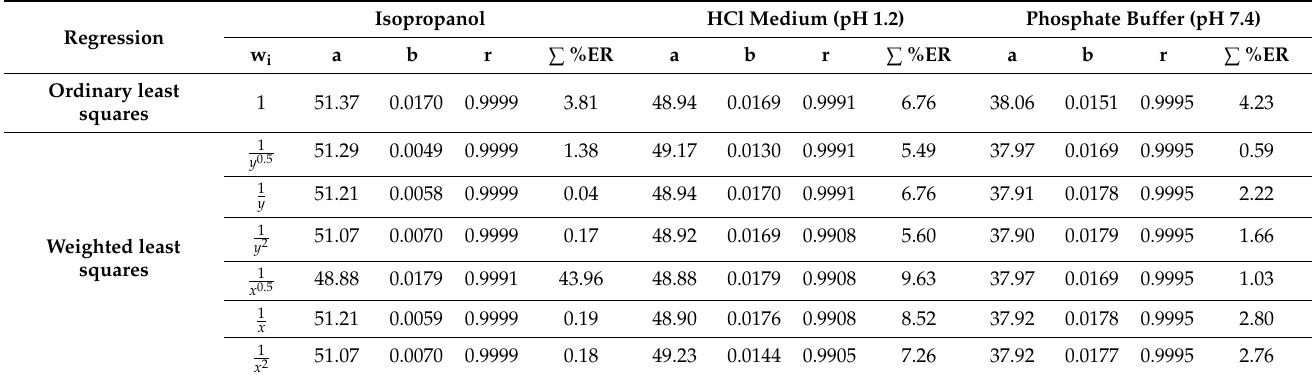
Table 3. Regression parameters of the analytical curve and sums of the relative errors ( Σ %RE).